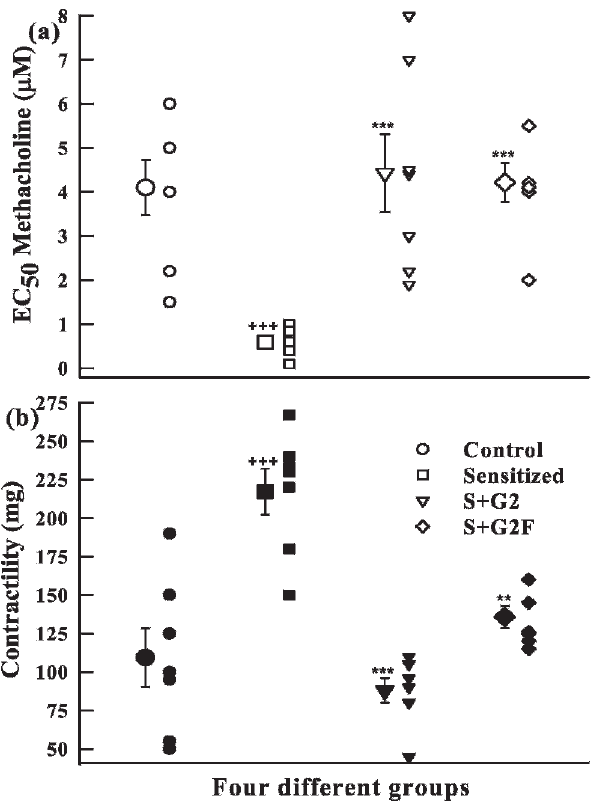
Figure 2 - Individual values and means ¡ SEMs (large symbols with bars) of the tracheal response to methacholine (EC 50 ) (a) and maximum contractility (b) in the four groups of guinea pigs (n=7): control (C), sensitized (S), S treated with adjuvant G2 (S + G2) and S treated with adjuvant G2F (S + G2F). Significant differences between the control and sensitized groups: +++ ; p , 0.001. Significant differences between the G2 and G2F groups vs the S group: **; p , 0.01, ***; p , 0.001. There was no significant difference in the EC 50 or maximum contractility between the S + G2 and S + G2F groups.